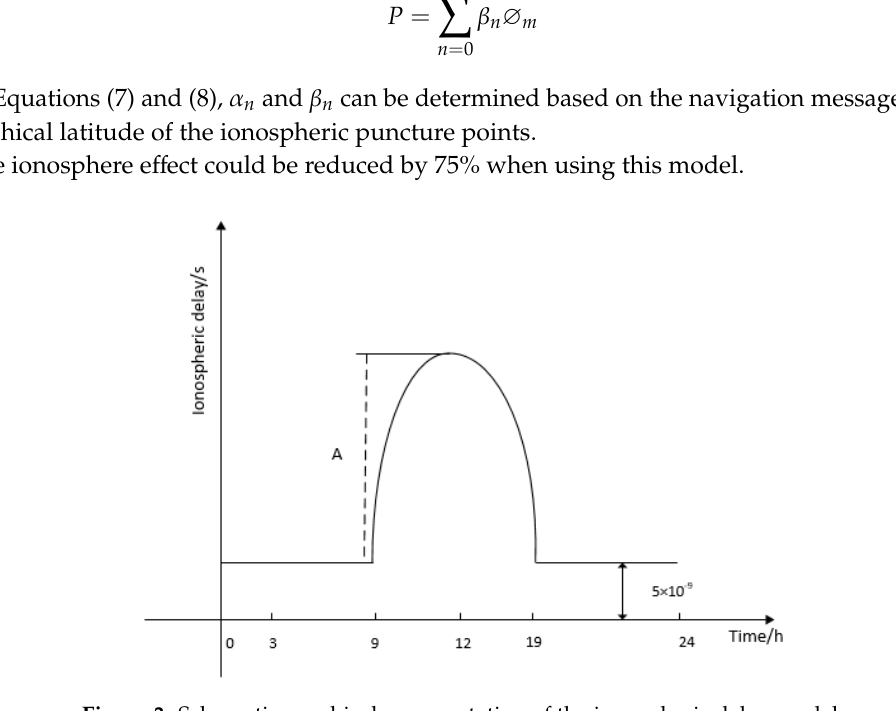
Figure 3. Schematic graphical representation of the ionospheric delay model.